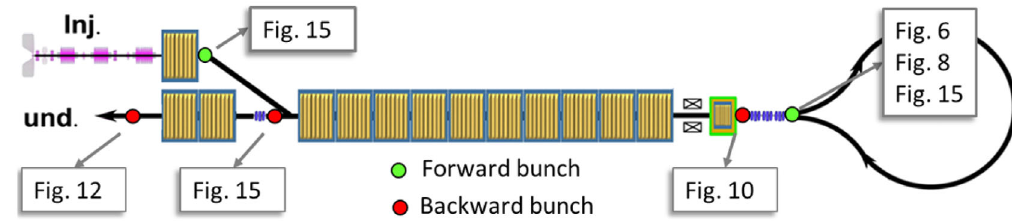
17. MariX ’ s beam line with positions of phase spaces shown in this